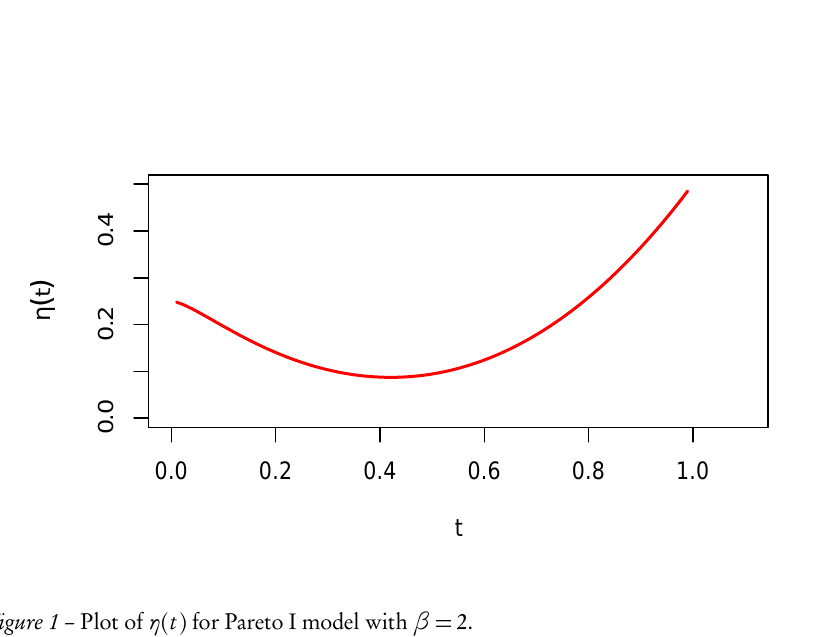
Figure 1 – Plot of η ( t ) for Pareto I model with β = 2.